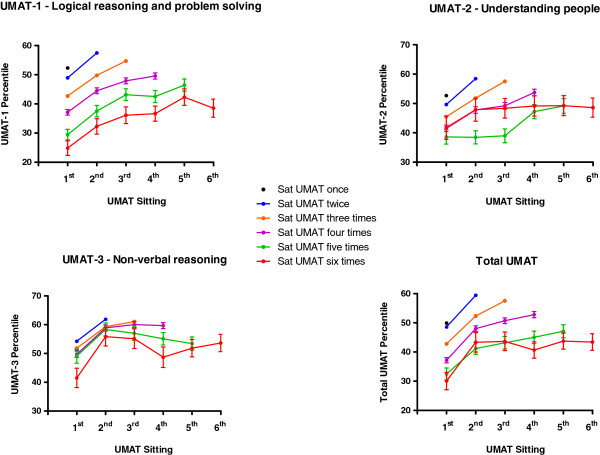
Total UMAT percentile score and percentile score in each of its 3 subsections (± SEM) by number of times candidates re-sat the test between 2000 and 2012. Error bars are absent where they are too small relative to the mean.